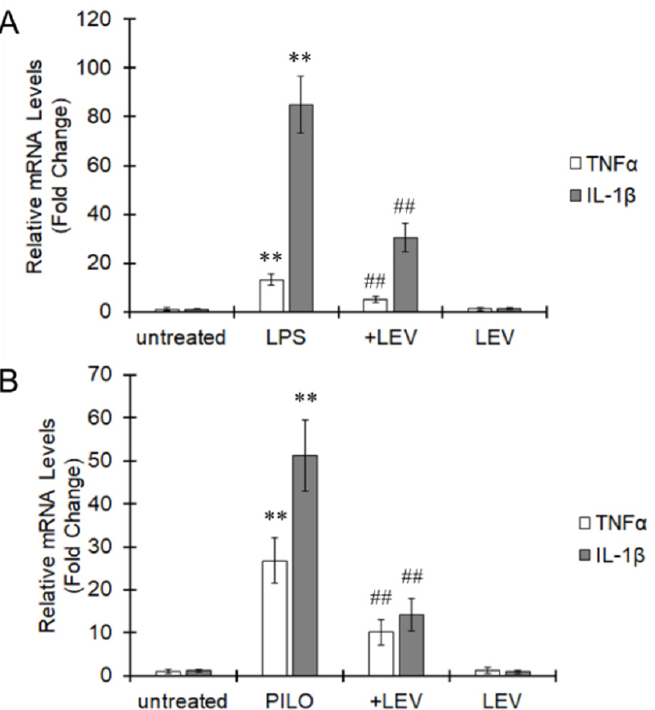
Figure 1. Suppression of proinflammatory cytokine expression by LEV. ( A ) BV-2 cells were pretreated with LEV for 20 min, and LPS was subsequently added for 24 h. Total RNA was extracted, and the mRNA expression of TNF α and IL-1 β was evaluated by real-time PCR. The values are presented as the mean ± S.E. of 5 separate experiments. The data were analyzed using ANOVA followed by Student (cid:48) s t -test. ** p < 0.01 vs. the untreated group and ## p < 0.01 vs. the LPS-treated group. ( B ) PILO was injected into mice and SE was terminated by diazepam. LEV was repeatedly admin- istered for 2 days. Total RNA was extracted from the hippocampus, and the mRNA expression of TNF α and IL-1 β were evaluated by real-time PCR. The values are presented as the mean ± S.E. ( n = 5 animals in each group). The data were analyzed using ANOVA followed by Student (cid:48) s t -test. ** p < 0.01 vs. naïve mice and ## p < 0.01 vs. PILO